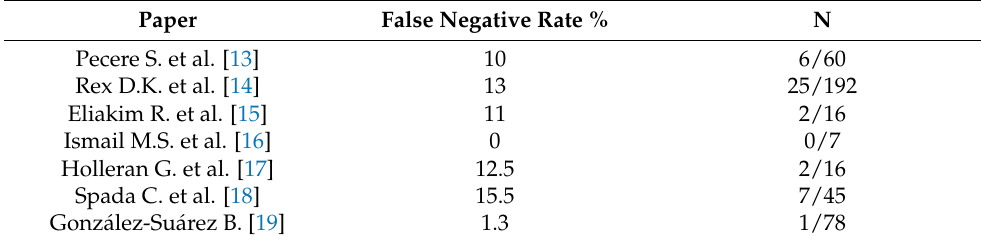
Table 1. CCE False Negative Rate for polyps > 6 mm compared to optical